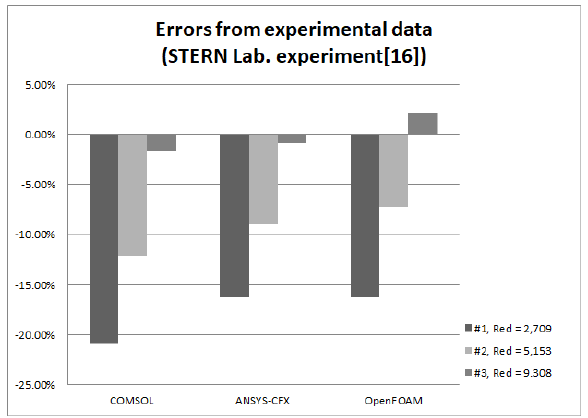
Figure 4. Comparison of numerical results from various codes for the experiment of STERN laboratory.